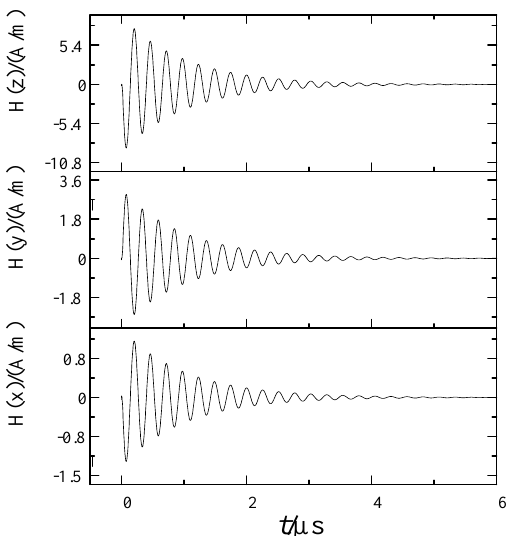
Figure 8. Current at secondary side of sensor (1 mm ball gap distance).